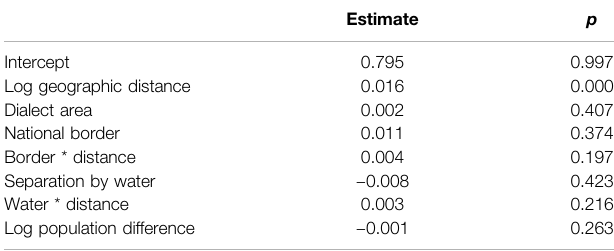
TABLE9| Multipleregressionoverdistancematrices(MRM)resultsforthe Society and education